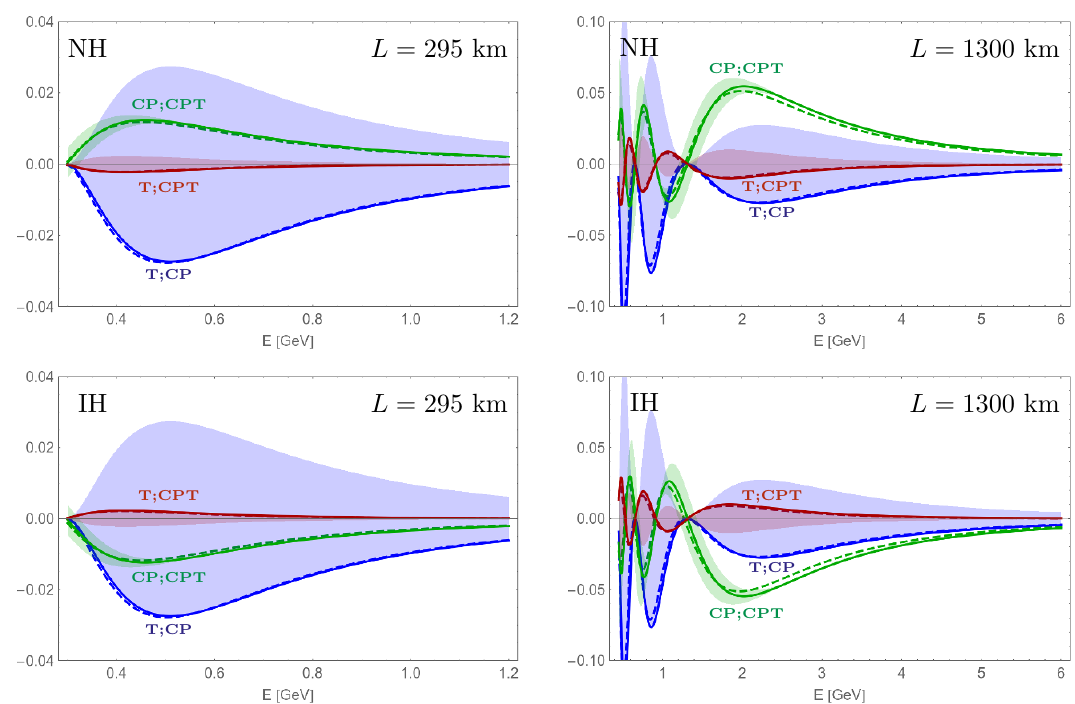
Figure 1. Comparison of the CP-odd CPT-invariant (blue) and the CP-invariant CPT-odd (red) components of the (cid:23) (cid:22) $ (cid:23) e T asymmetry, together with the matter-induced CPT-odd T-invariant (green) component of the CP asymmetry. Each label near the lines indicates the two symmetries un- der which the corresponding asymmetry component is odd. Lines show A T;CP